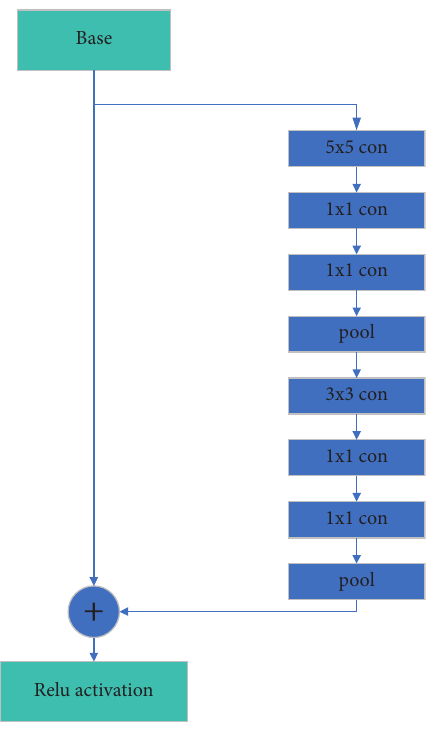
Figure 17: The overall structure of MBR.